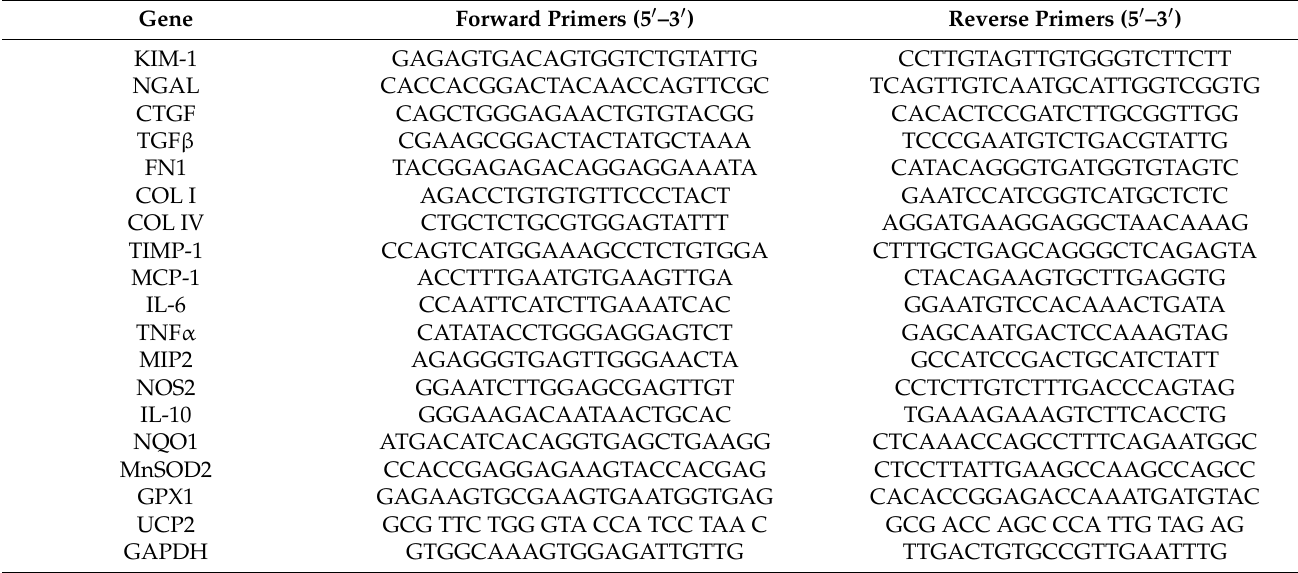
Table 1. The primer sequences used for real-time PCR analysis in this study.